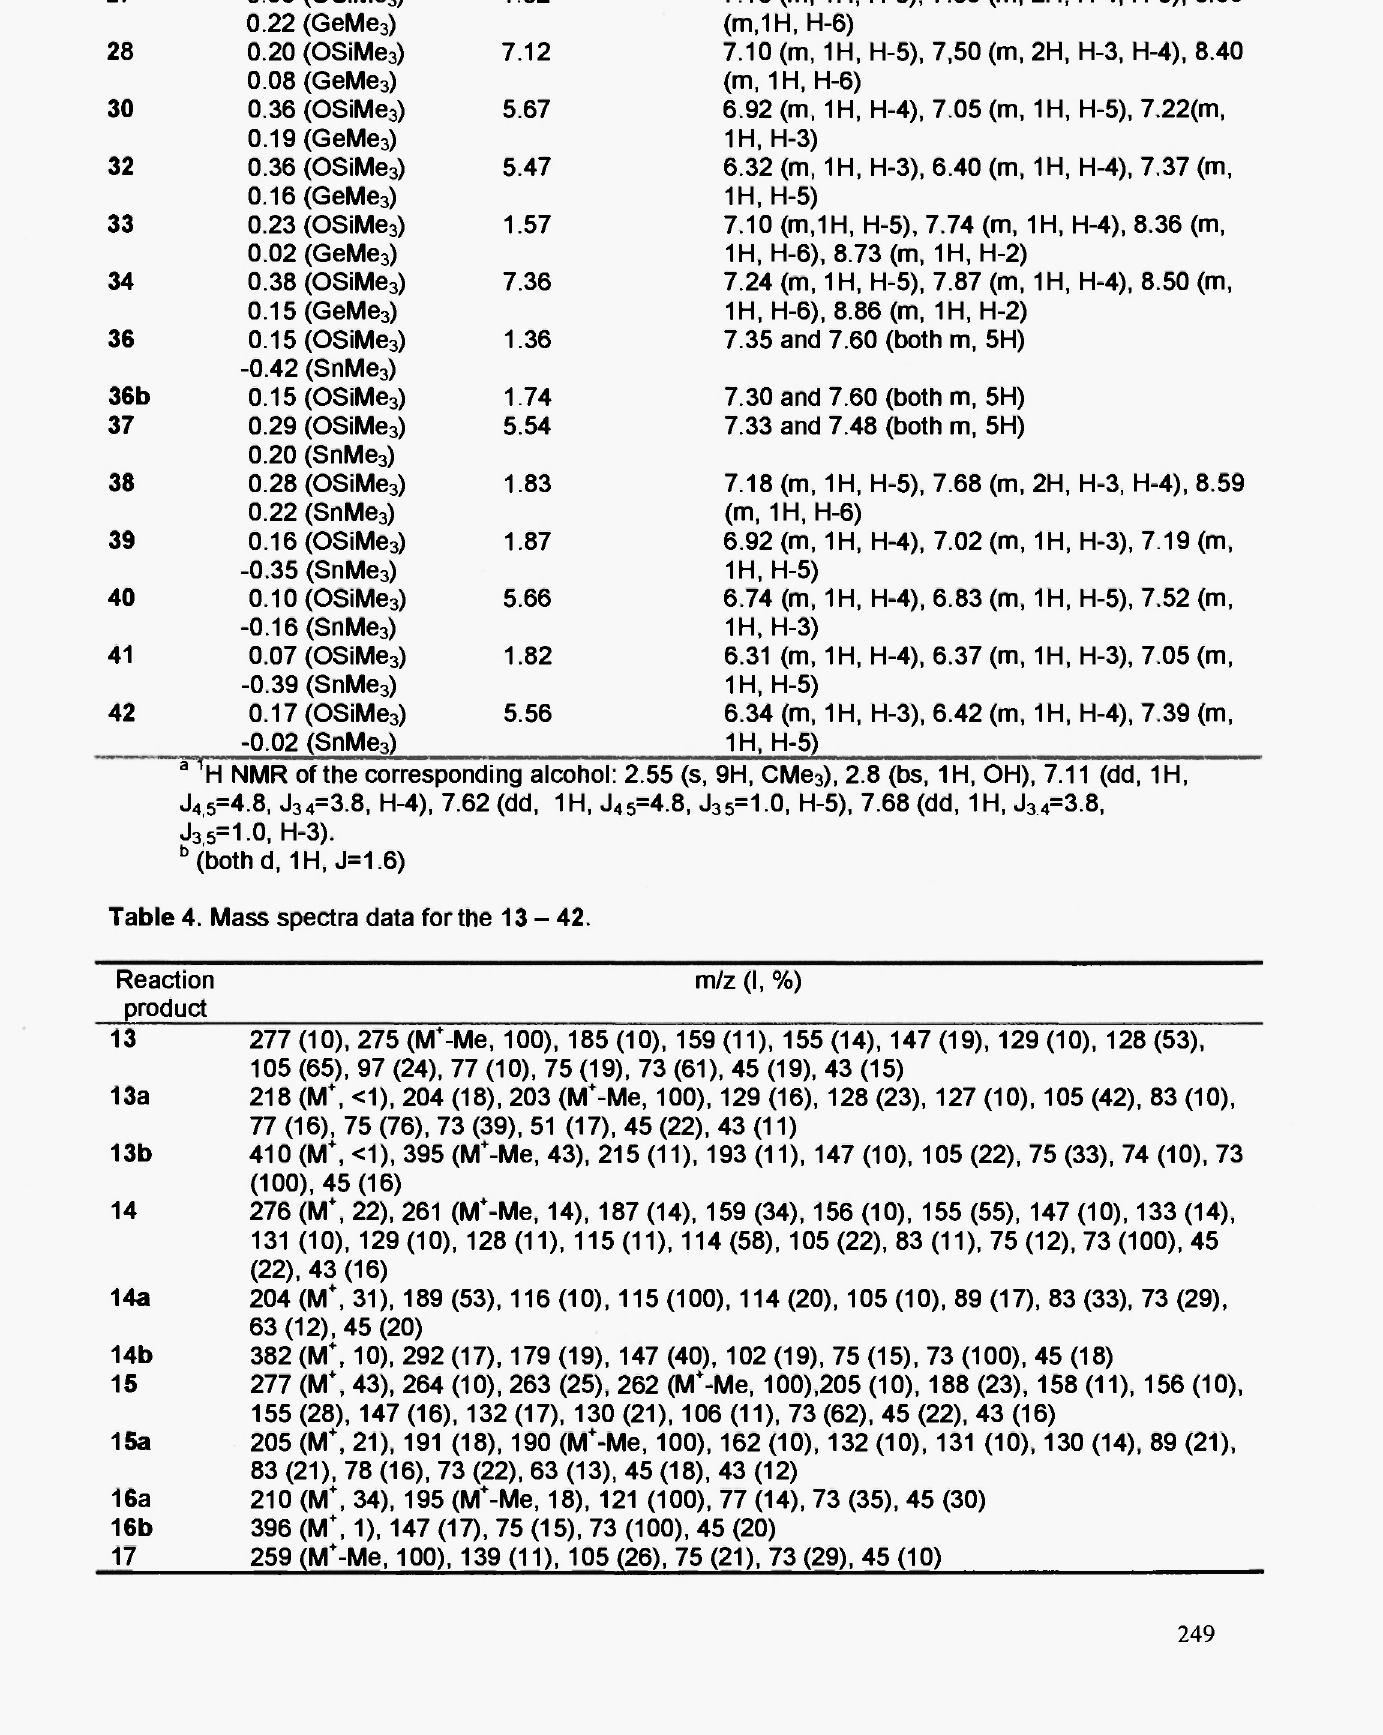
Table 4. Mass spectra data for the